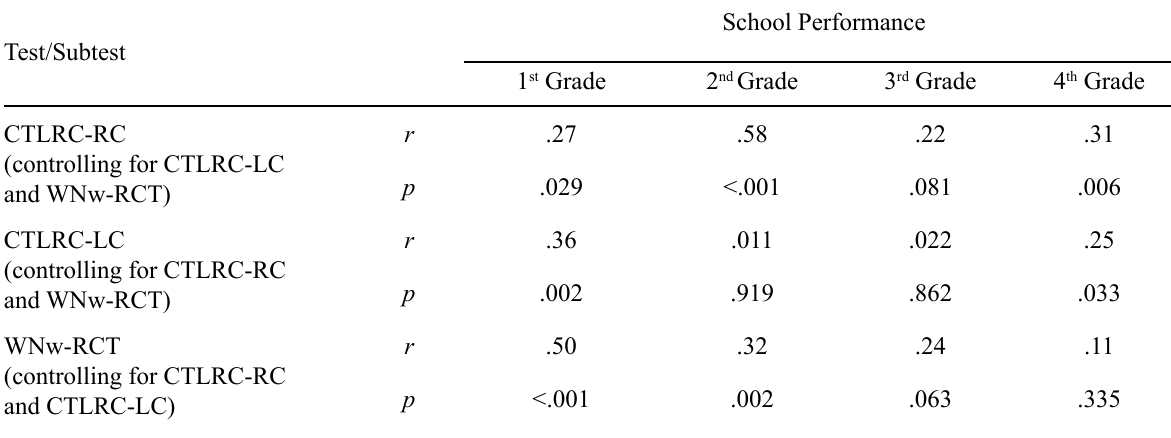
Partial Correlation Matrix, With Pearson’s Correlation Coef fi cients and Signi fi cance, Between School Performance and the Scores on the CTLRC and WNw-RCT in Each Grade Level